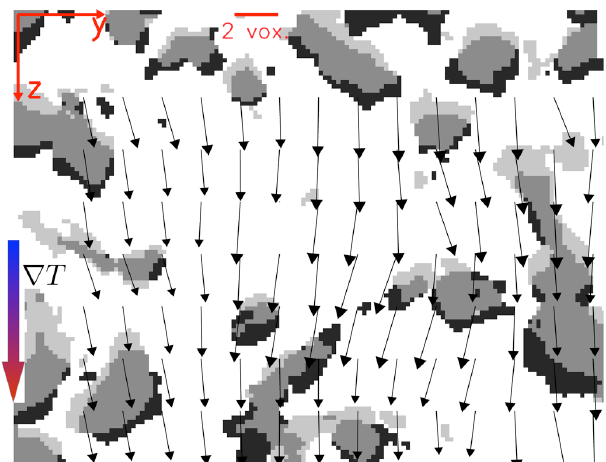
Fig. 3. A slice of a displacement vector field calculated in three dimensions. Light grey represents sublimated voxels and dark grey freshly deposited voxels; mid-gray indicates no change with respect to the previous image. The reference system and the scale for the displacement vectors are shown on top, the temperature gradient was pointing downward. The physical dimensions of the presented slice are 2 . 5 × 1 . 9mm 2